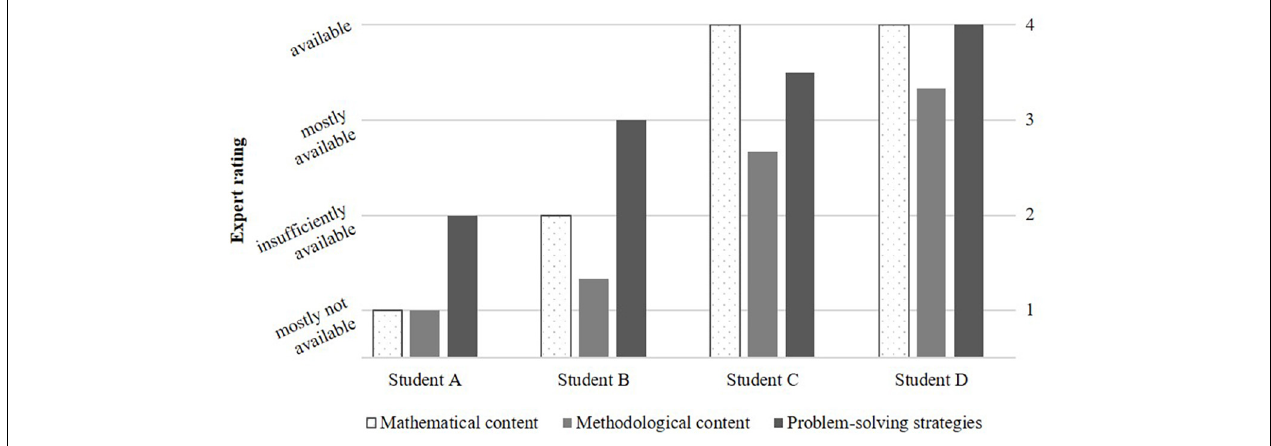
FIGURE 2 | Availability of central prerequisites for the simulated students’ mathematical argumentation